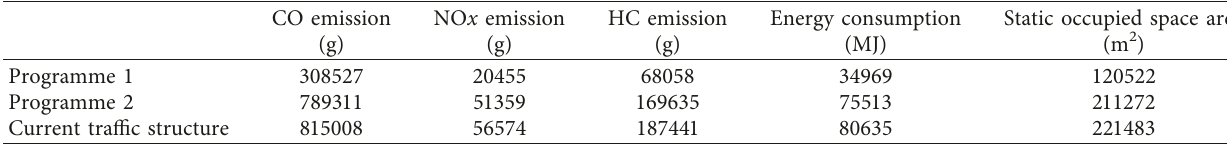
Table 5: Environmental indicators under the two travel modes.